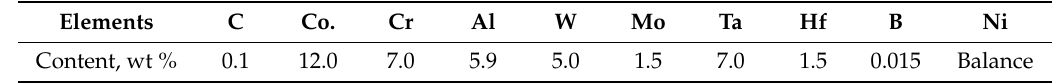
Table 1. Chemical composition of IC10 alloy (wt %). Elements C Co. Cr Al W